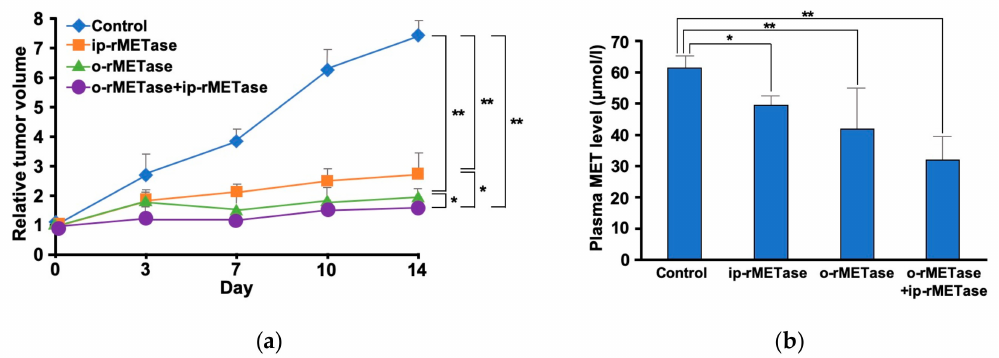
Figure 4. The first report of oral administration of recombinant methioninase (o-rMETase) for melanoma patient-derived orthotopic xenograft (PDOX). ( a ) Comparison of treatment e ffi cacy on oral administration of recombinant methioninase (o-rMETase) and intraperitoneal injection (i.p.-rMETase) for BRAF mutant melanoma PDOX. ( b ) Plasma methionine level treated after recombinant methioninase (rMETase). ** p < 0.01, * p < 0.05, error bars show the SD [47].